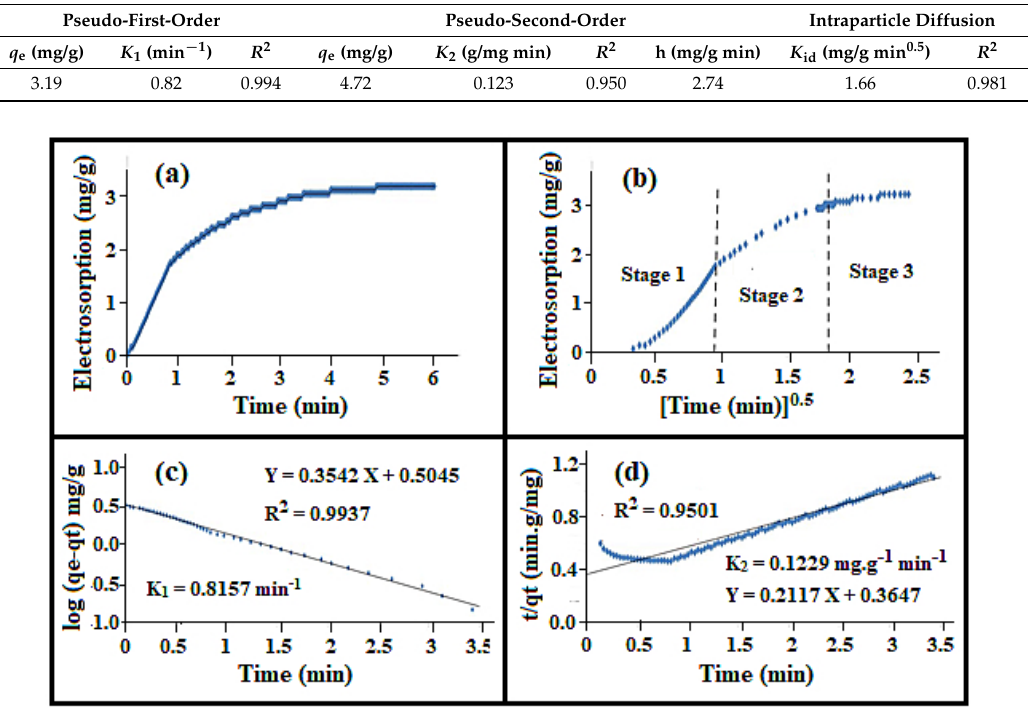
Figure 11. The ( a ) electrosorption; ( b ) intraparticle diffusion; ( c ) pseudo-first-order adsorption kinetics; and ( d ) pseudo-second-order adsorption kinetics of NaCl onto the 23.58 wt% a-SWCNT-coated RVC electrode at a flow rate of 50 mL/min and a voltage of 1.5